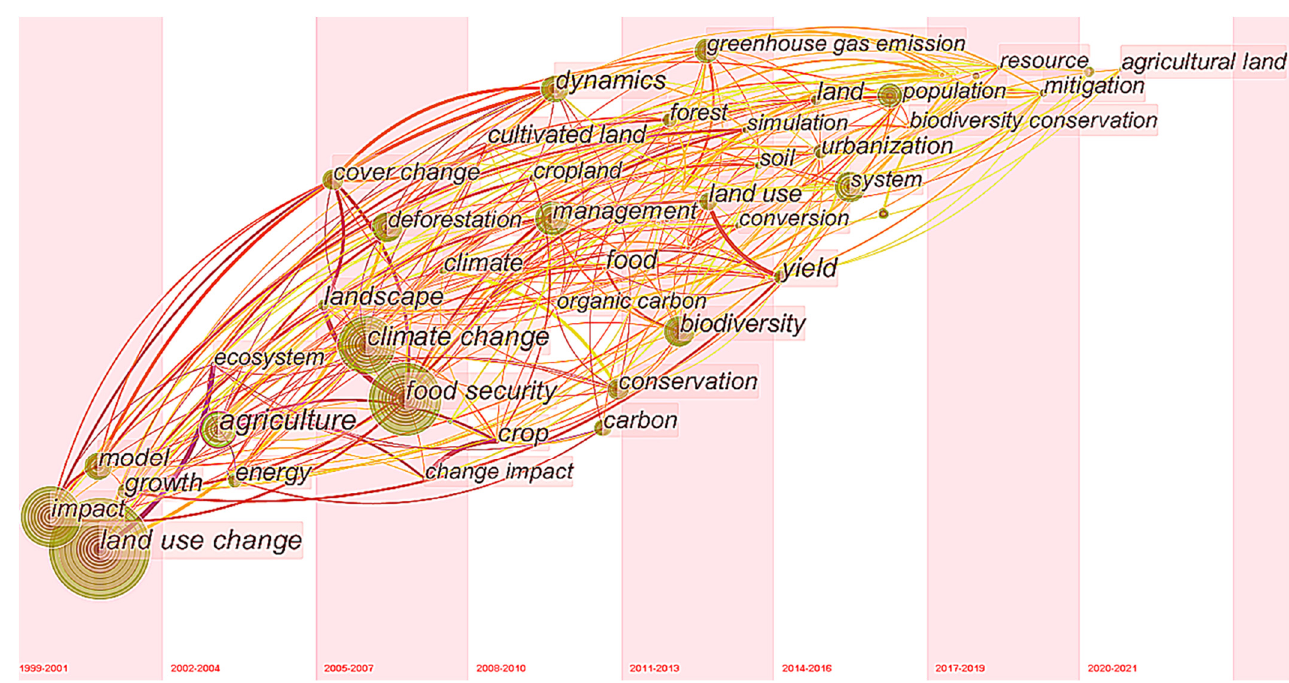
Figure 7. Time zone map for studying the evolution path produced by CiteSpace software. Table 6. Top three burst keywords detection with the CiteSpace software.